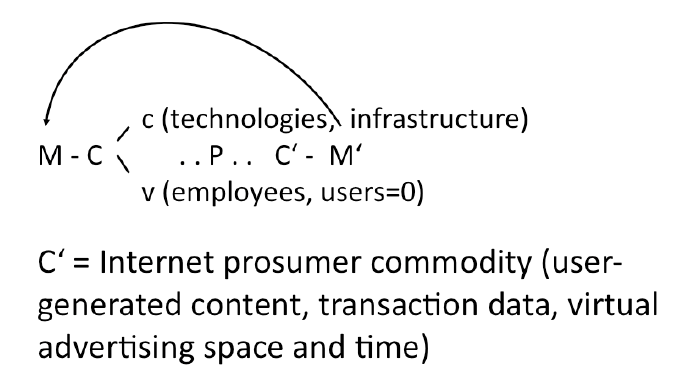
Figure 1. Capital accumulation on